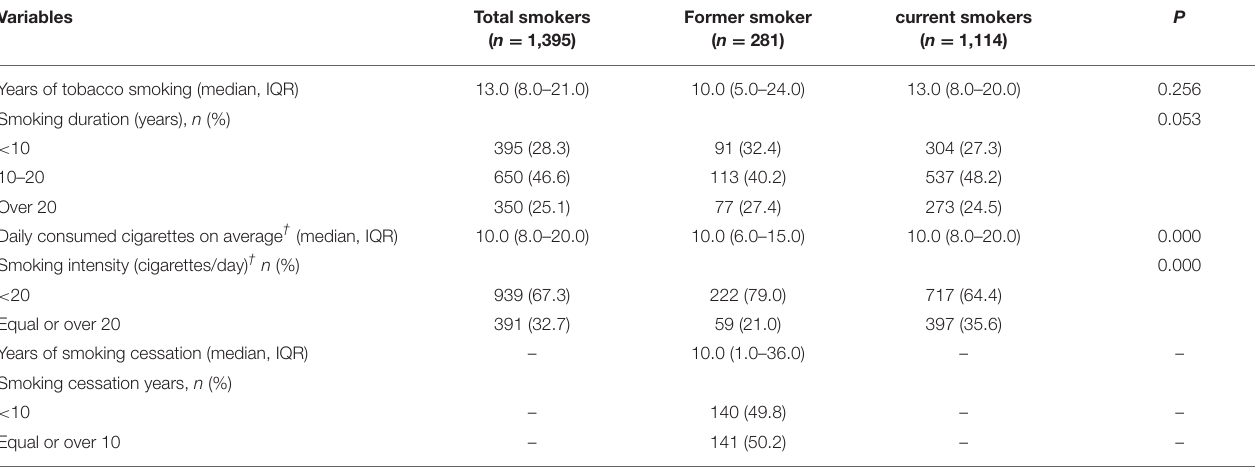
TABLE 2 | The smoking intensity, smoking duration, tobacco expenses, and smoking cessation attempt among current smokers in rural area of Shanghai, China.